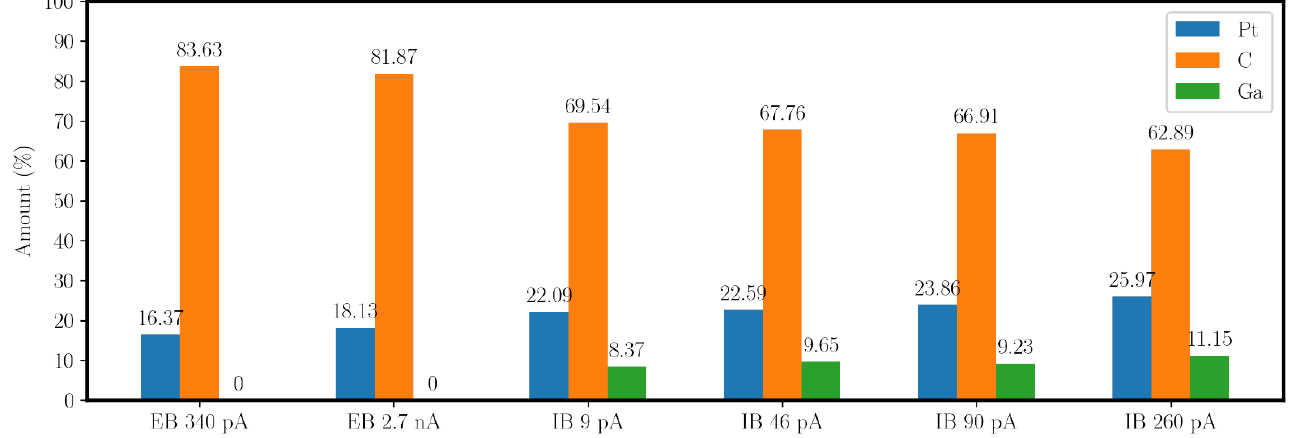
Figure 6. The EDX analysis yields two FEBID tips with 340 pA and 2.7 nA and four FIBID tips with 9, 46, 90, and 260 pA. The FIBID tips each contain a Ga amount, which is not present in the FEBID tips due to the technology.